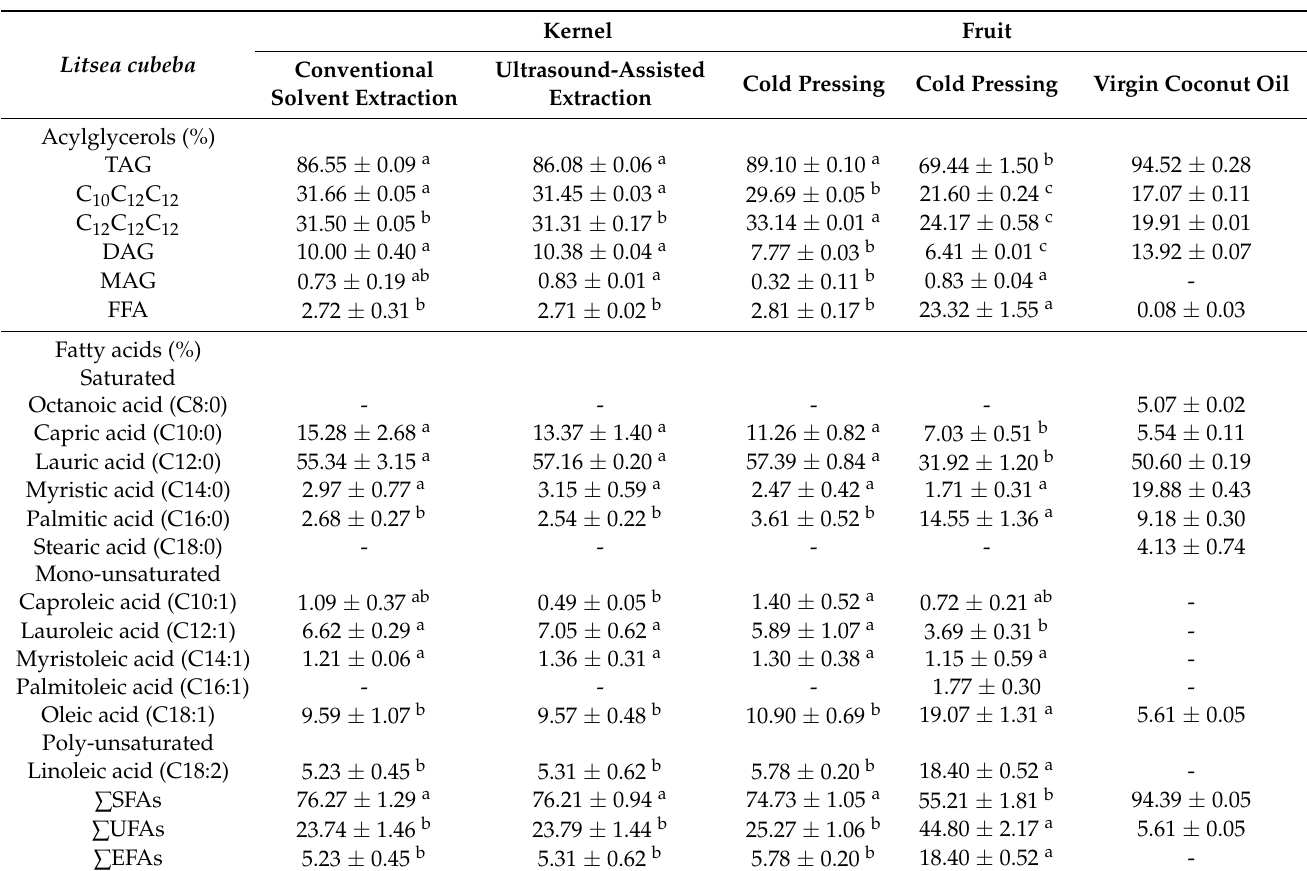
Table 1. The effect of different extraction methods on the composition of acylglycerols and fatty acids in Litsea cubeba